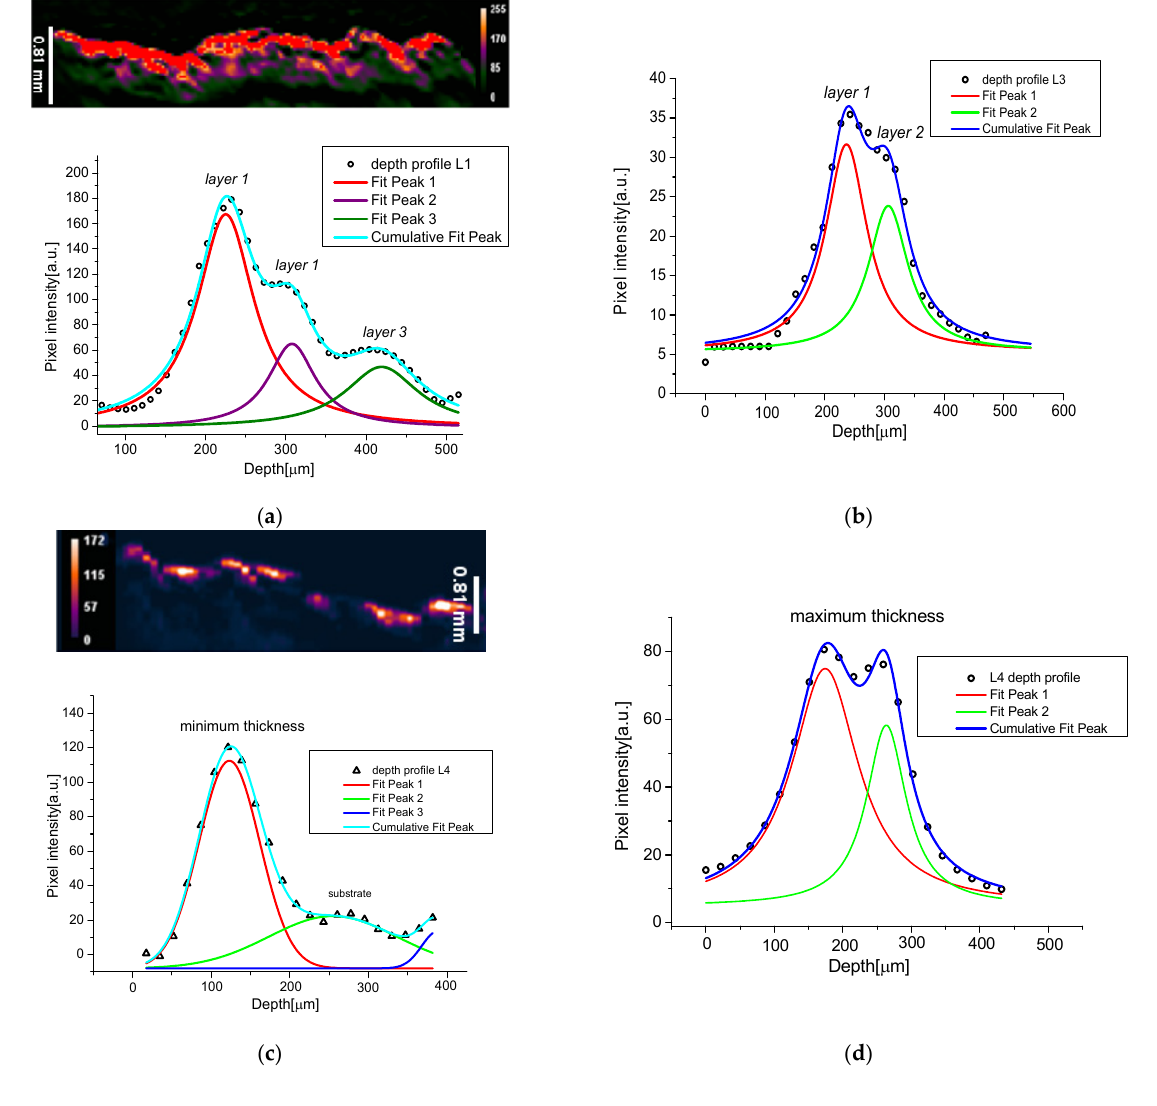
Figure 4. Stratigraphic profile fit obtained by PA imaging for sample F.01 the different painted lines: ( a )z-profileofL1; ( b )z-profileofL3; z-profileofL4zone,maximum( c )andminimum( d